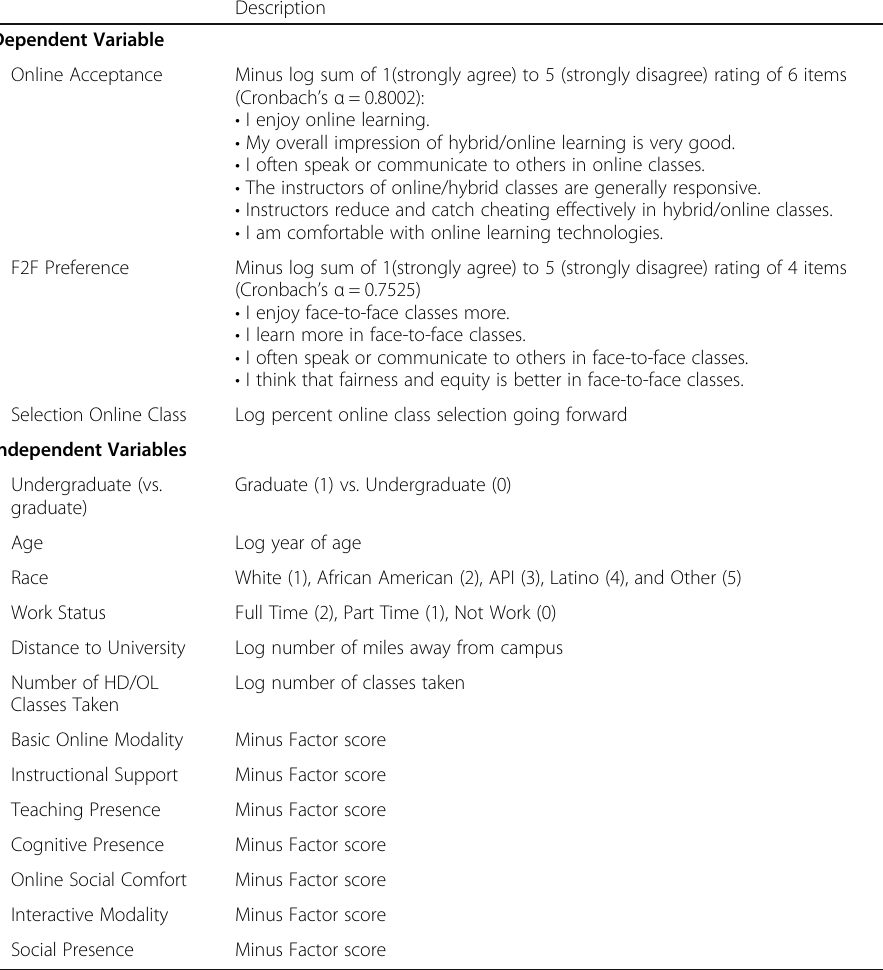
Table 5 Description of Variables